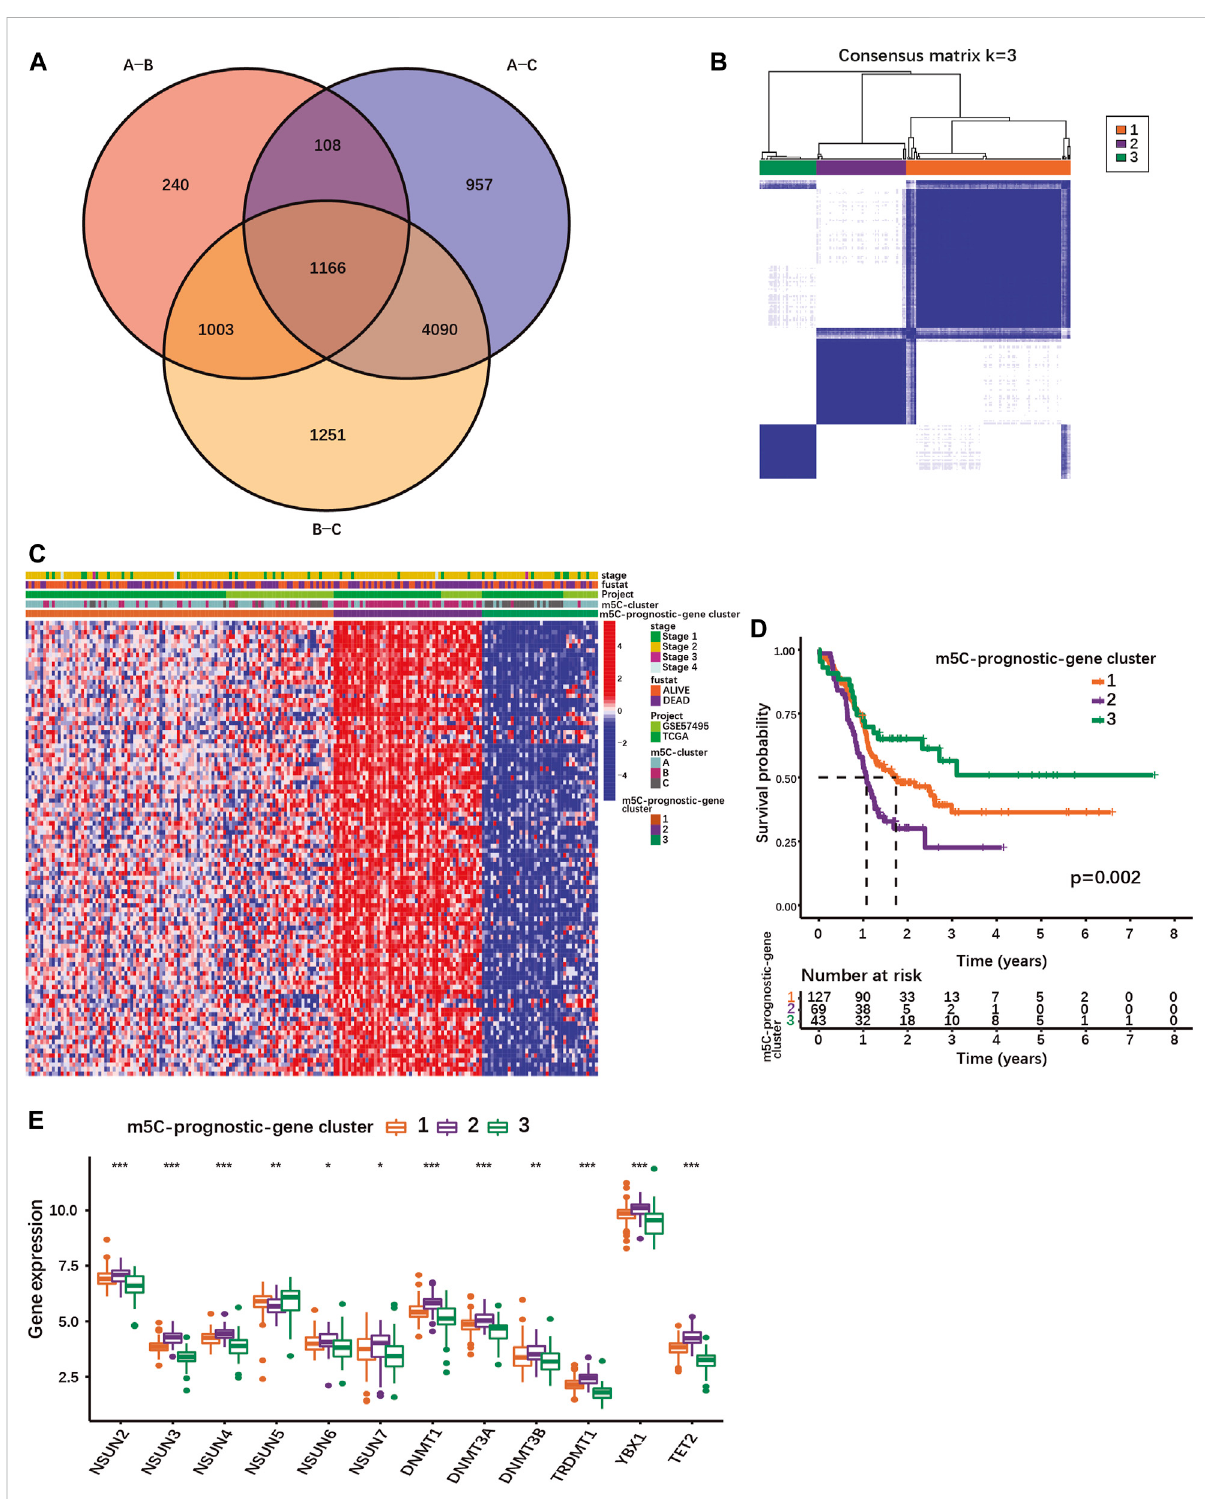
FIGURE 2 Identi fi cation of different PDAC subgroups based on m5C-related prognostic DEGs. (A) Venn diagram showing 1166 DEGs between different m5C-clusters. (B) Consensus matrix for optimal k = 3 clusters using the TCGA-PAAD and GSE57495 cohorts analyzed by unsupervised consensus clustering analyses based on the 1166 m5C-related prognostic DEGs. (C) Heatmap showing the expression of m5C-related prognostic DEGs with survival status, stage, m5C-clusters, m5C-prognostic-gene clusters. Columns represented patients and rows m5C-related prognostic DEGs. (D) The K-M curves show OS for m5C-prognostic-gene clusters 1/2/3 analyzed by log-rank test in the TCGA-PAAD and GSE57495 cohorts. (E) Expression of m5C-regulators in the three m5C-prognostic-gene clusters; * p < 0.05; ** p < 0.01; *** p <